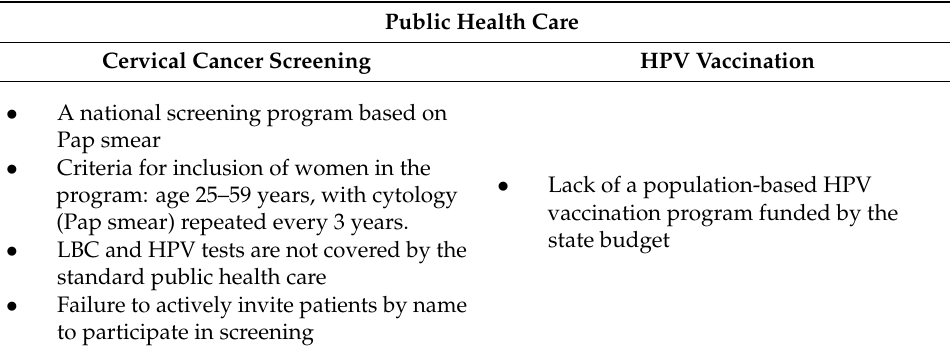
Table 1. The principles of CC prevention in public health care in Poland.